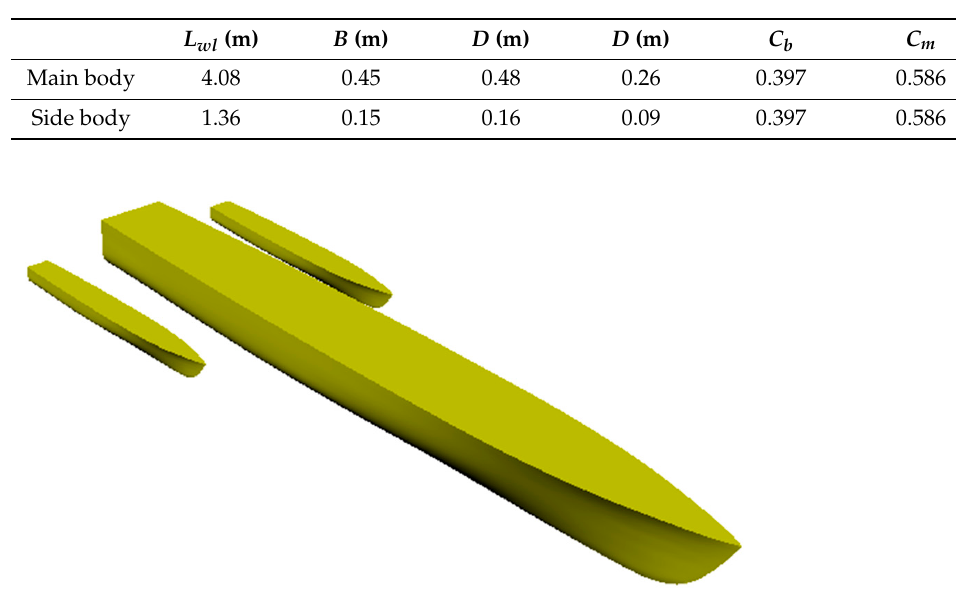
Table 10. The size information of trimaran.